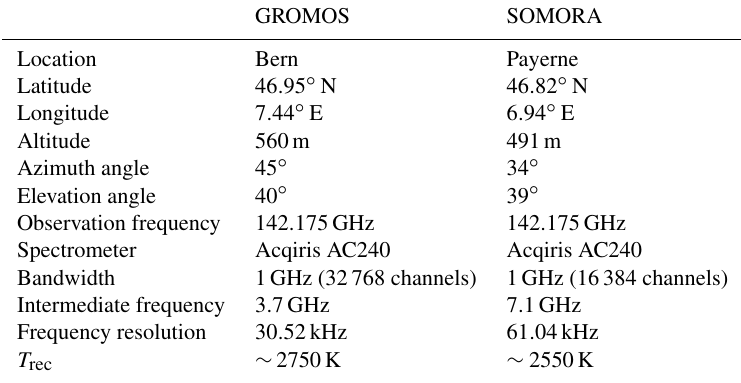
Table 1. GROMOS and SOMORA microwave